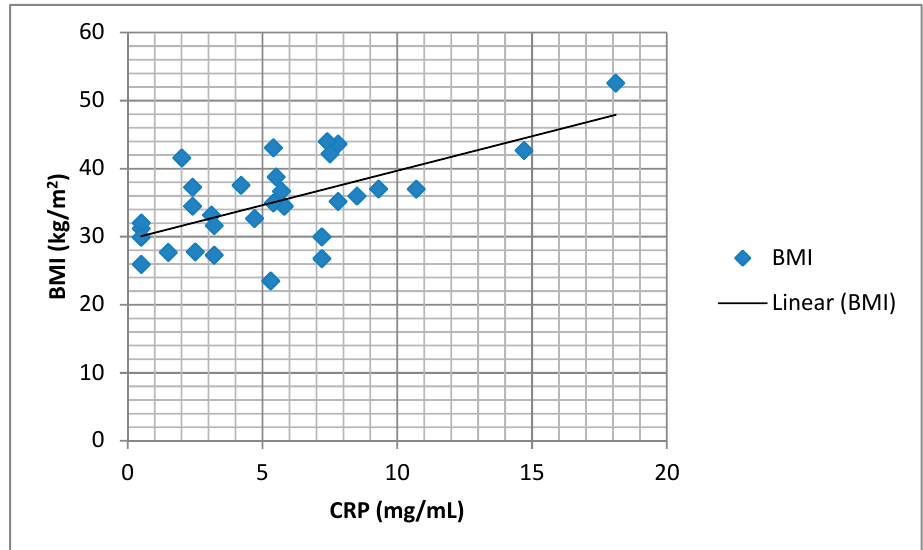
Figure 2. Correlation of serum CRP and body mass index (BMI) ( r = 0.633, p = 0.000) .